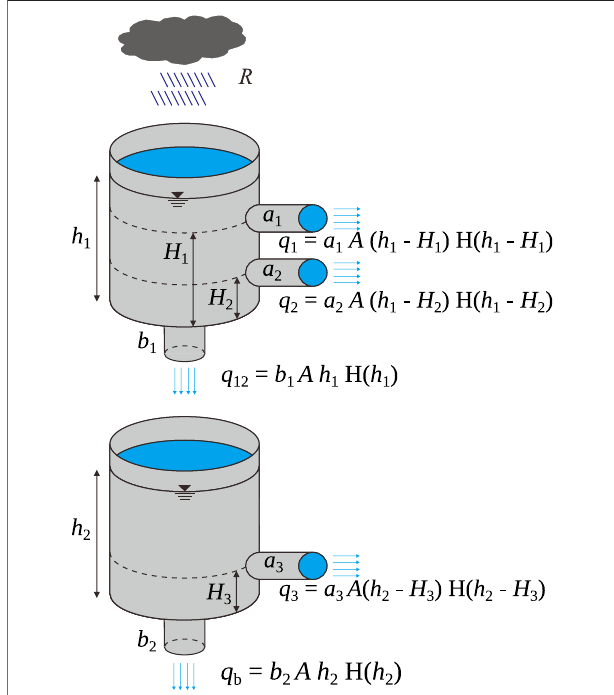
FIGURE 6 | Conceptual sketch of tank model. The model has two tanks with an identical area A . Rainfall intensity (RI), given by R ( t ), is the water input source ( h 1 , h 2 ) are the tank water levels, ( q 1 , q 2 , q 3 ) are discharge rates, and ( q 12 , q b ) are in fi ltration rates. Parameters ( a 1 , a 2 , a 3 ) are discharge coef fi cients and ( b 1 , b 2 ) are in fi ltration coef fi cients. The initial values of ( h 1 , h 2 ) aredenoted as( S 1 , S 2 )(notshowninthe fi gure).Thetotalwaterdepth, h 1 + h 2 is referred to as the water storage index (WSI) in the present study. H ( · ) is the Heaviside function to ensure uni-directional water discharge and in fi ltration. In applications, A is the area of the